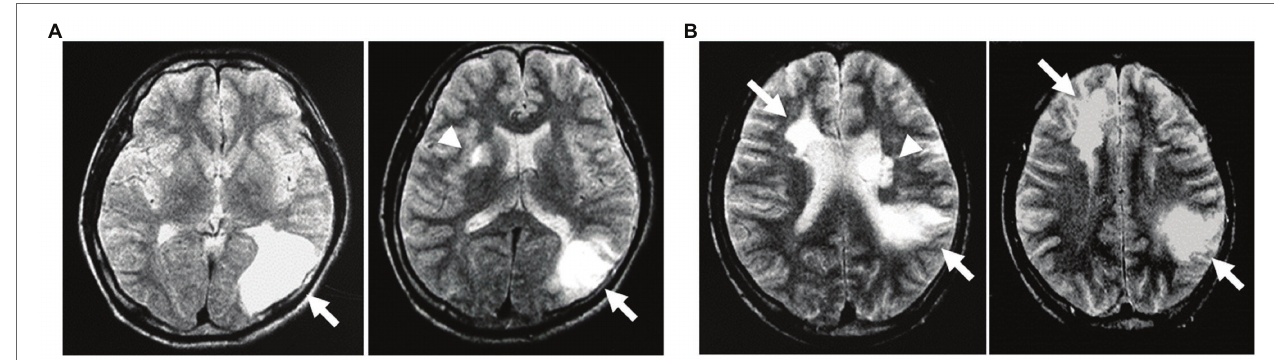
FIGURE 3 | MRI of the brain in a 33-year-old assisted Ama diver with right homonymous hemianopsia. T2-weighted MRI obtained on the 4th day after the diving event shows two increased signal intensities in the left occipital lobe (arrow) and the right basal ganglia (arrow head; A ). A 39-year-old assisted male Ama diver with right-sided hemiparesis and hemisensory numbness. He suffered from transient left hemiparesis at the age of 17, 25, and 27 years, and his T2-weighted MRI on the 3rd day after the event shows three increased signal intensities in the right frontal lobe and left parietal lobe (arrows) and the left basal ganglia (arrow head; B ; taken from Kohshi et al., 2000 with